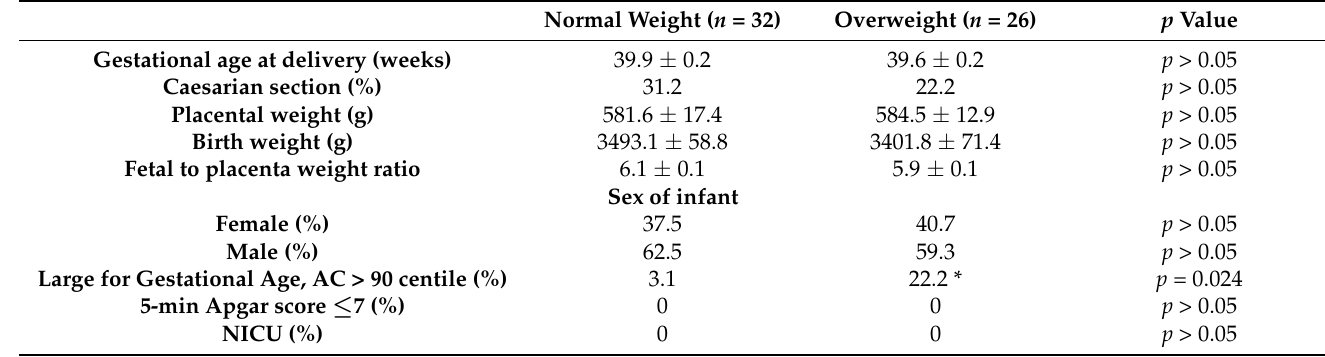
Table 3. Fetal outcomes in normal weight and overweight pregnancies. Values are expressed as mean ± ES and percentage. Significant differences ( p < 0.05): * differences indicating a significant effect compared with normal weight. t -test and chi-square test were used.